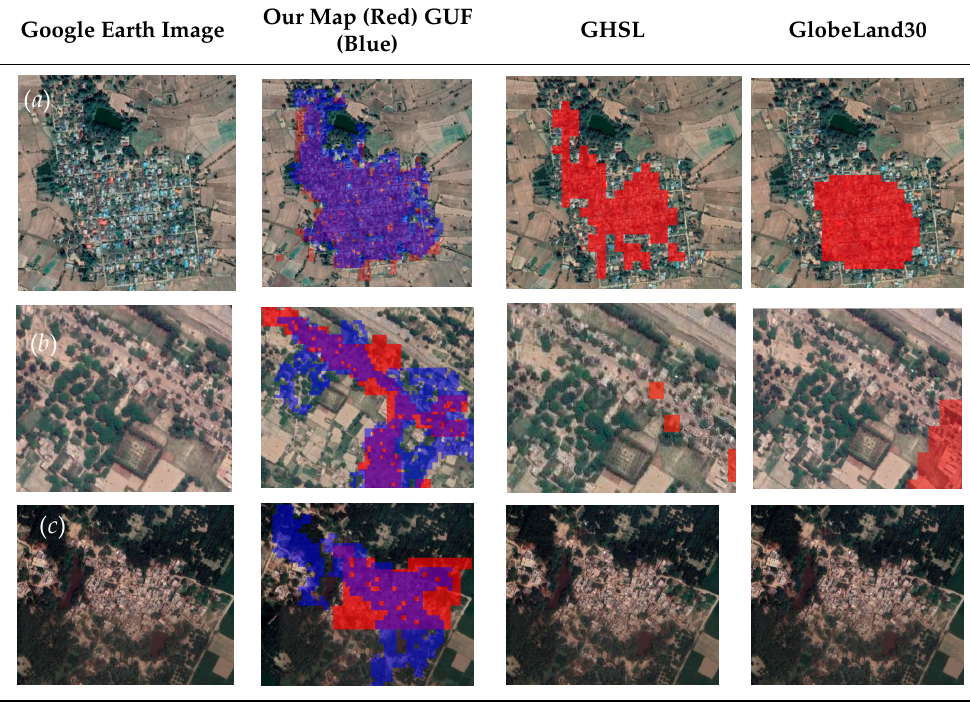
Table 3. The example of algorithm performance for extracted rural settlements of three selected cases (a), (b) and (c). Here, the GUF and our map were overlaid to highlight their differences.